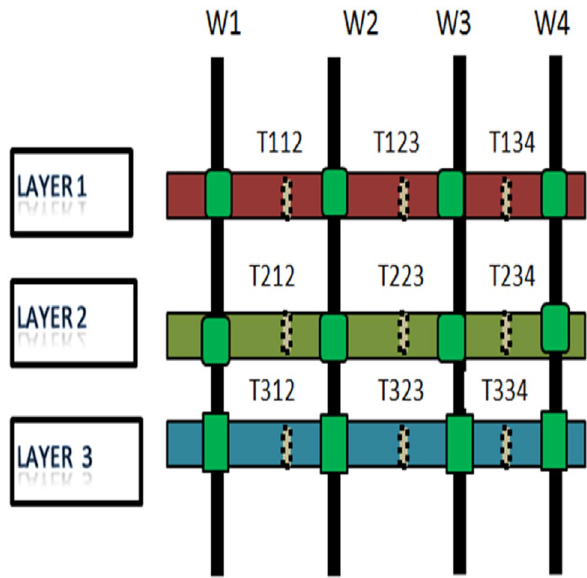
Fig. 1 Example completion schematic for MCCR model (three sepa- rated layers and each layer is divided into four